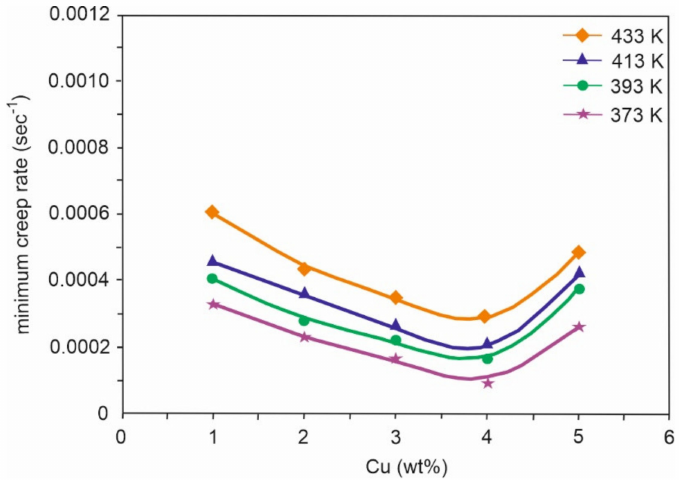
Figure 21. Variation of creep rates concerning change in wt% of Cu